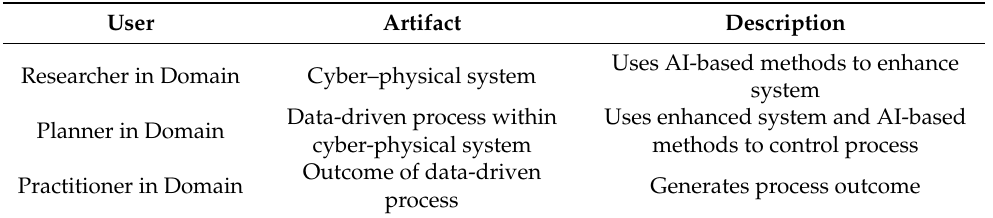
Table 1. Domain-specific user